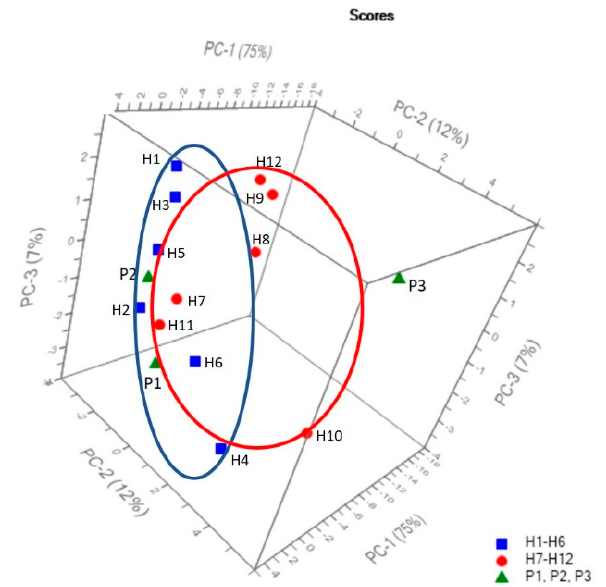
Figure 7. Principal component analysis (PCA) score 3D plots of PC-1 vs. PC-2 and PC-3 obtained for the 15 FT-IR spectra corresponding to the P1–P3 and H1–H12 samples, respectively: P1–P3 and H1–H12 are labelled for clear visualization.